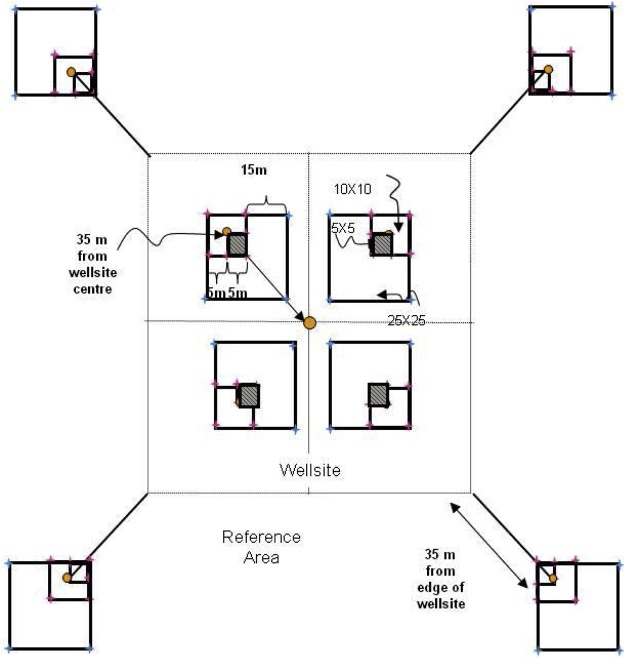
More detailed scale of 5 × 5 m, 10 × 10 m, and 25 × 25 m plot sampling.Shrub and 2-D cover are measured in the 5 × 5 m plots (shaded in grey) identified in the figure.